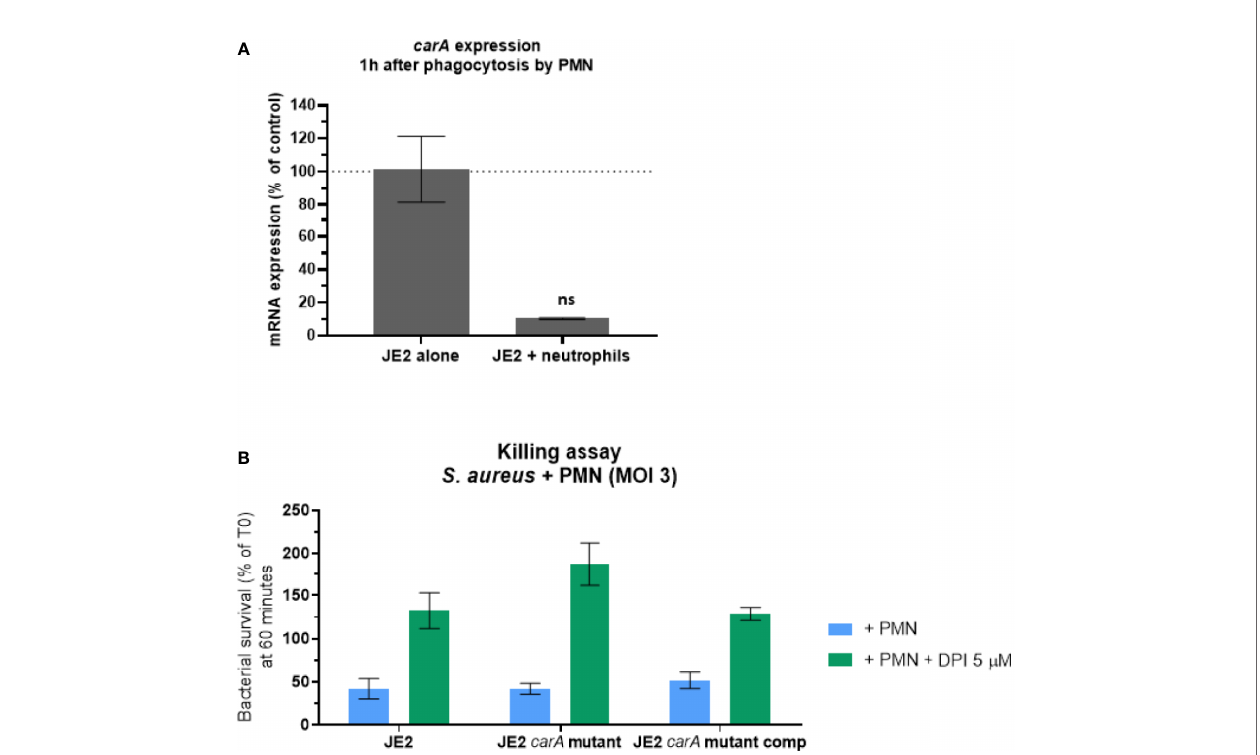
FIGURE 7 | carA expression and S. aureus survival 60 minutes after phagocytosis by human neutrophils. (A) Expression analysis of carA with qPCR one hour after phagocytosis by human neutrophils. Gene expression was normalized with the gene expression in non-phagocytosed bacteria. These results represent the mean ± SD of two independent experiments. (B) Bacterial survival was estimated after 60 minutes of co-culture with human neutrophils with a multiplicity of infection (MOI) of 3. ROS production inside the phagosome was either conserved (blue) or inhibited (green) by 5 µM of diphenyleneiodonium (DPI). CFU counts following the experiment were normalized according CFU count from the initial inoculum. These results represent the mean ± SD of three independent experiments. ns, not signi fi cant, p>0.05 by Kruskal-Wallis